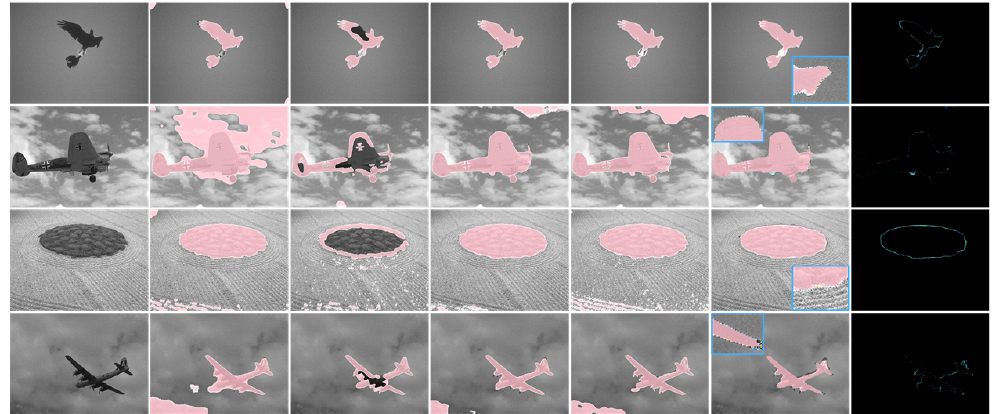
Figure 5. The comparison results on natural images. The first column is the images to be segmented, the middle five columns are the segmentation result of the five methods (CV [8], RSF [11], FEBAC [15], RLSF [31], and ours) and the last column is the uncertainty degree generated by our method.